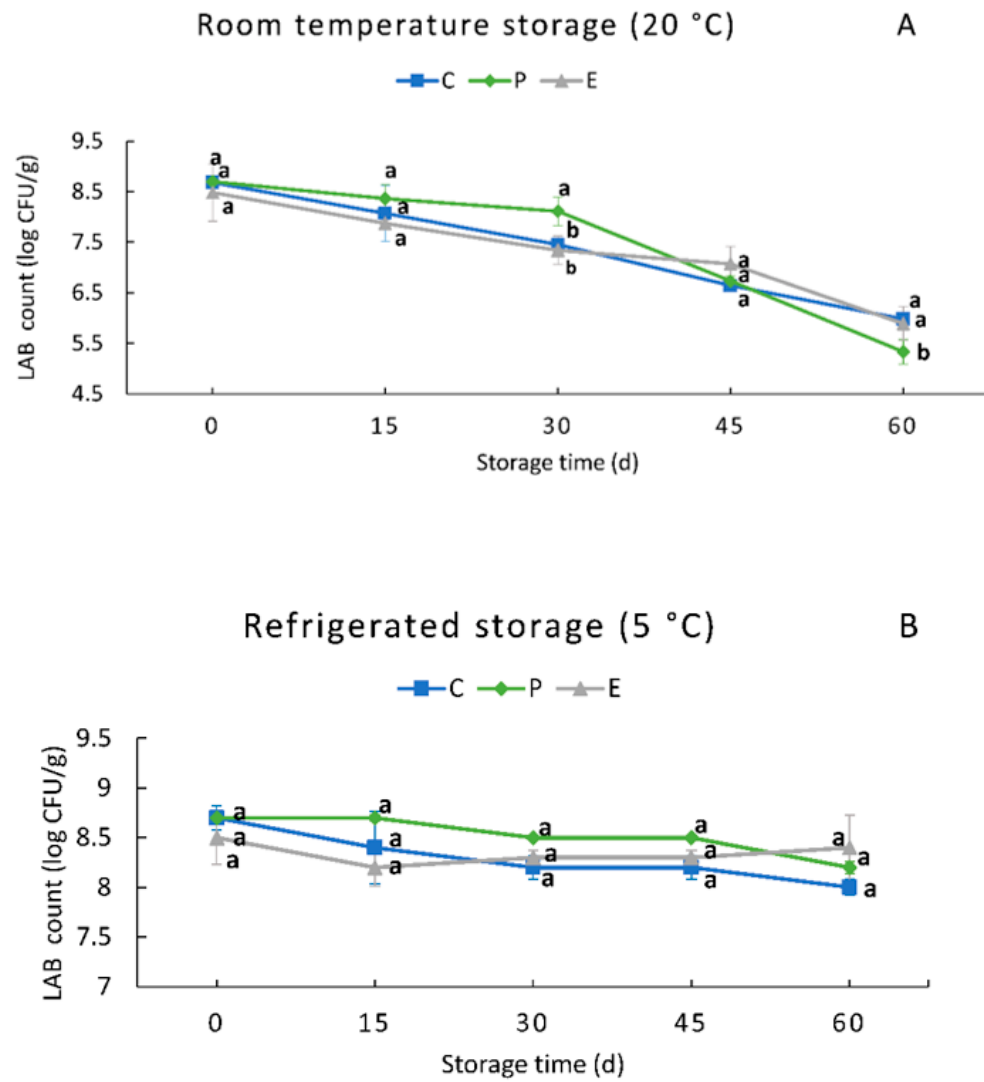
Figure 4. ( A ) : LAB counts (means ± standard deviations) during 60 d of room temperature storage (20 °C) of Salamines Criollos formulated with microencapsulated L. plantarum BFL (E) and free L. plantarum BFL. ( B ) : LAB counts (means ± standard deviations) during 60 d of refrigerated storage (5 °C) of Salamines Criollos formulated with microencapsulated L. plantarum BFL (E) and free L. plantarum BFL (P). The different letters indicate significant differences between treatments on the same day under the same storage temperature.